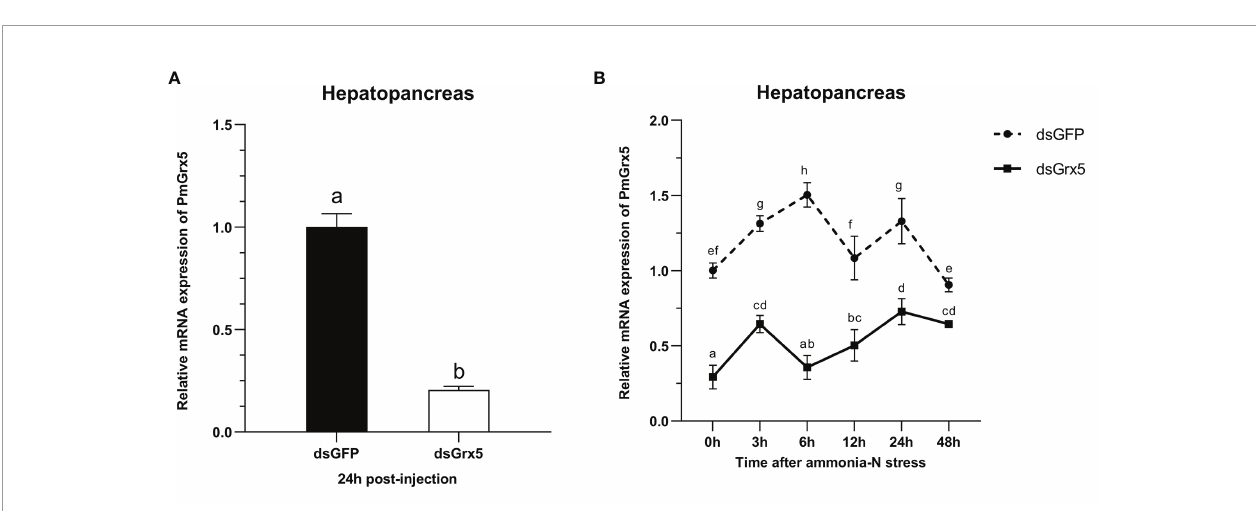
FIGURE 8 | (A) mRNA expression levels of PmGrx5 in the hepatopancreas at 24 h after dsRNA injection. (B) Expression pro fi le of PmGrx5 in the hepatopancreas of dsRNA-injected shrimps within 48 h under ammonia-N stress. The data are presented as mean ± SD ( n = 3). Different letters denote signi fi cant differences ( P < 0.05).